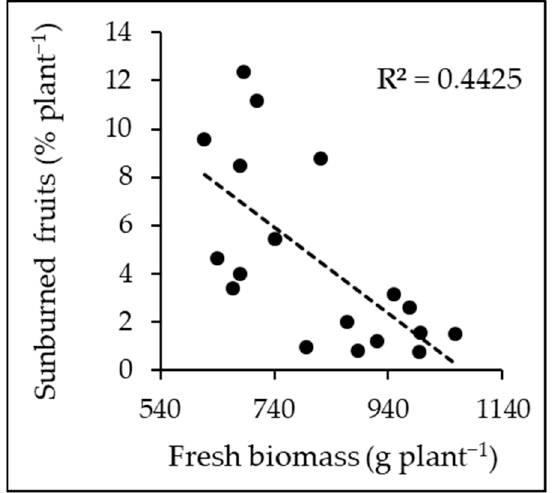
Figure 6. Relationship between biomass and sunburned fruits ( p < 0.01) (n = 18).